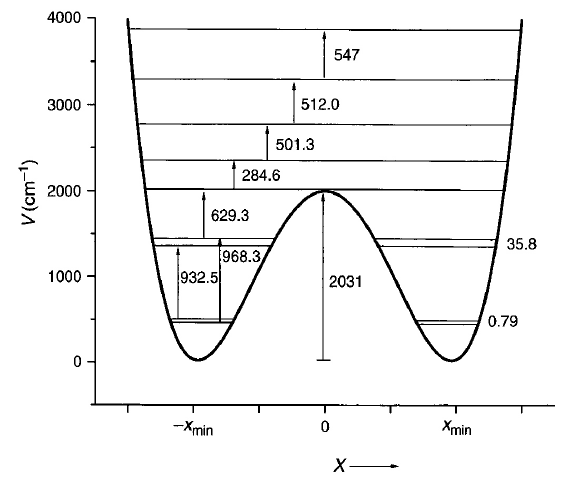
Figure 1. Umbrella mode potential for NH 3 with transition and level splittings indicated [9,10].